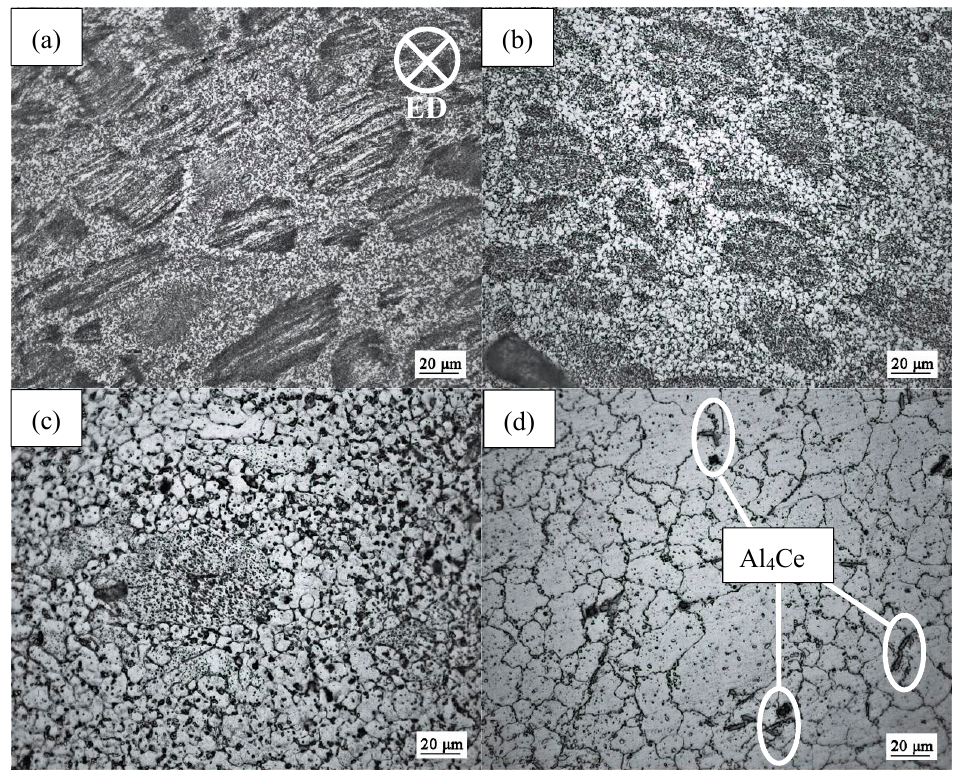
Figure 8. OM images of AZ80 + 0.4%Ce magnesium alloys after first pass extension with different temperatures: ( a ) 270 °C, ( b ) 310 °C, ( c ) 350 °C, ( d ) 390 °C.